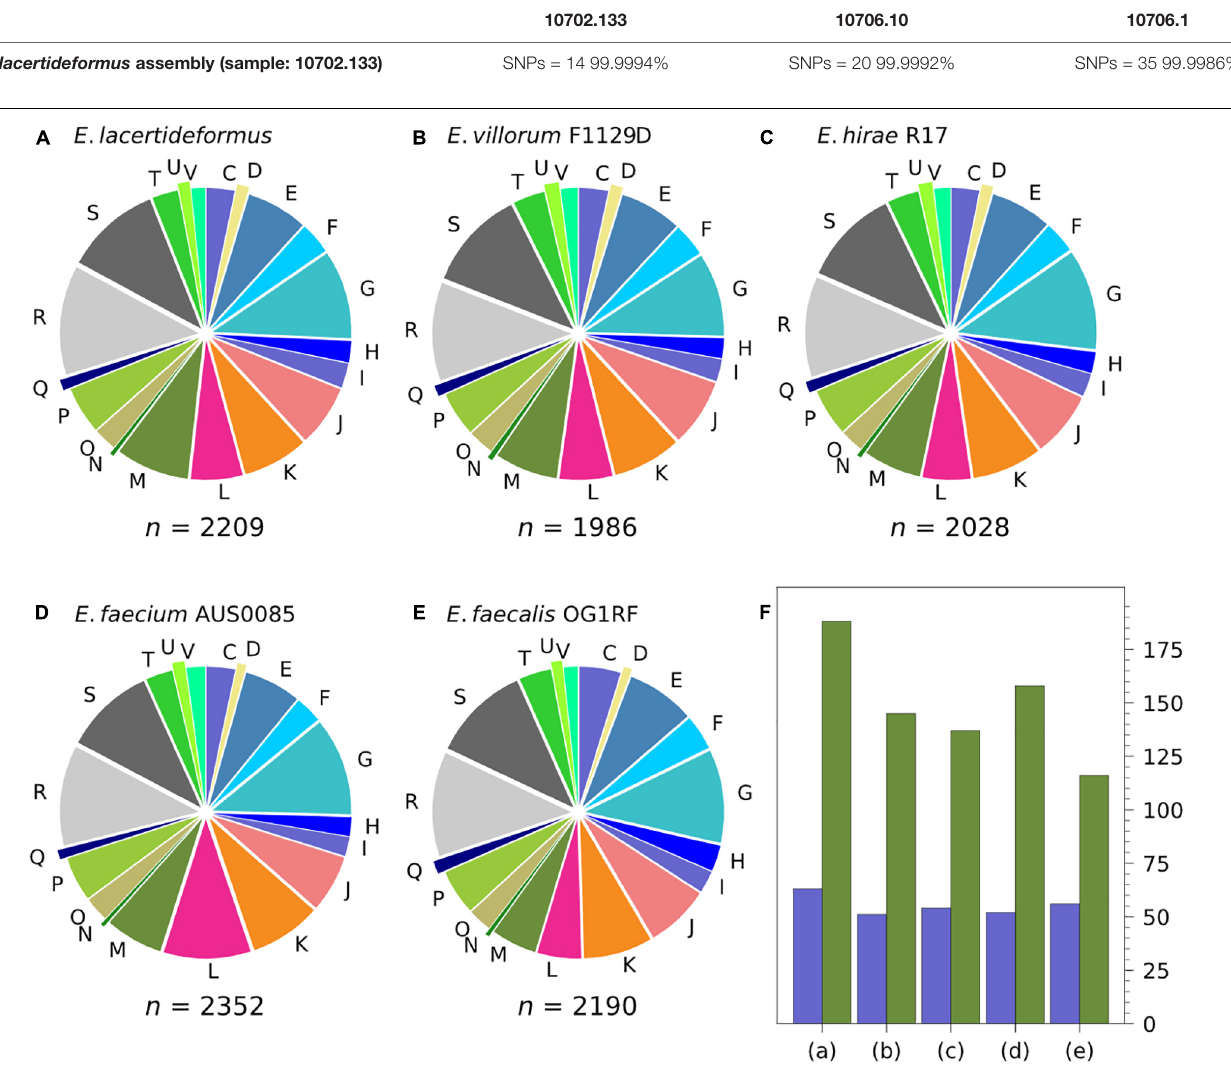
FIGURE 3 | Classification of COGs in E. lacertideformus and comparator genomes by feature categories. The proportions of COGs by features common across (A) E. lacertideformus, (B) E. villorum F1129D, (C) E. hirae R17, (D) E. faecium AUS0085, and (E) E. faecalis OG1RF are illustrated. A total count of these common COGs for each genome are shown below the respective chart. One letter abbreviations for the features: [C], energy production and conversion; [D], cell cycle control, cell division, chromosome partitioning; [E], amino acid transport and metabolism; [F], nucleotide transport and metabolism; [G], carbohydrate transport and metabolism; [H], coenzyme transport and metabolism; [I], lipid transport and metabolism; [J], translation, ribosomal structure and biogenesis; [K], transcription; [L], replication, recombination and repair; [M], cell wall/membrane/envelope biogenesis; [N], cell motility; [O], posttranslational modification, protein turnover, chaperones; [P], inorganic ion transport and metabolism; [Q], secondary metabolites biosynthesis, transport and catabolism; [R], general function prediction only; [S], function unknown; [T], signal transduction mechanisms; [U], intracellular trafficking, secretion and vesicular transport; [V], defense mechanisms. The bar chart (F) illustrates the number of COGs ( y -axis) for the [M] (green) and [I] (purple) functional groups which showed the largest disparity between (A) E. lacertideformus, and comparator genomes (B) E. villorum, (C) E. hirae, (D) E. faecium, and (E) E. faecalis